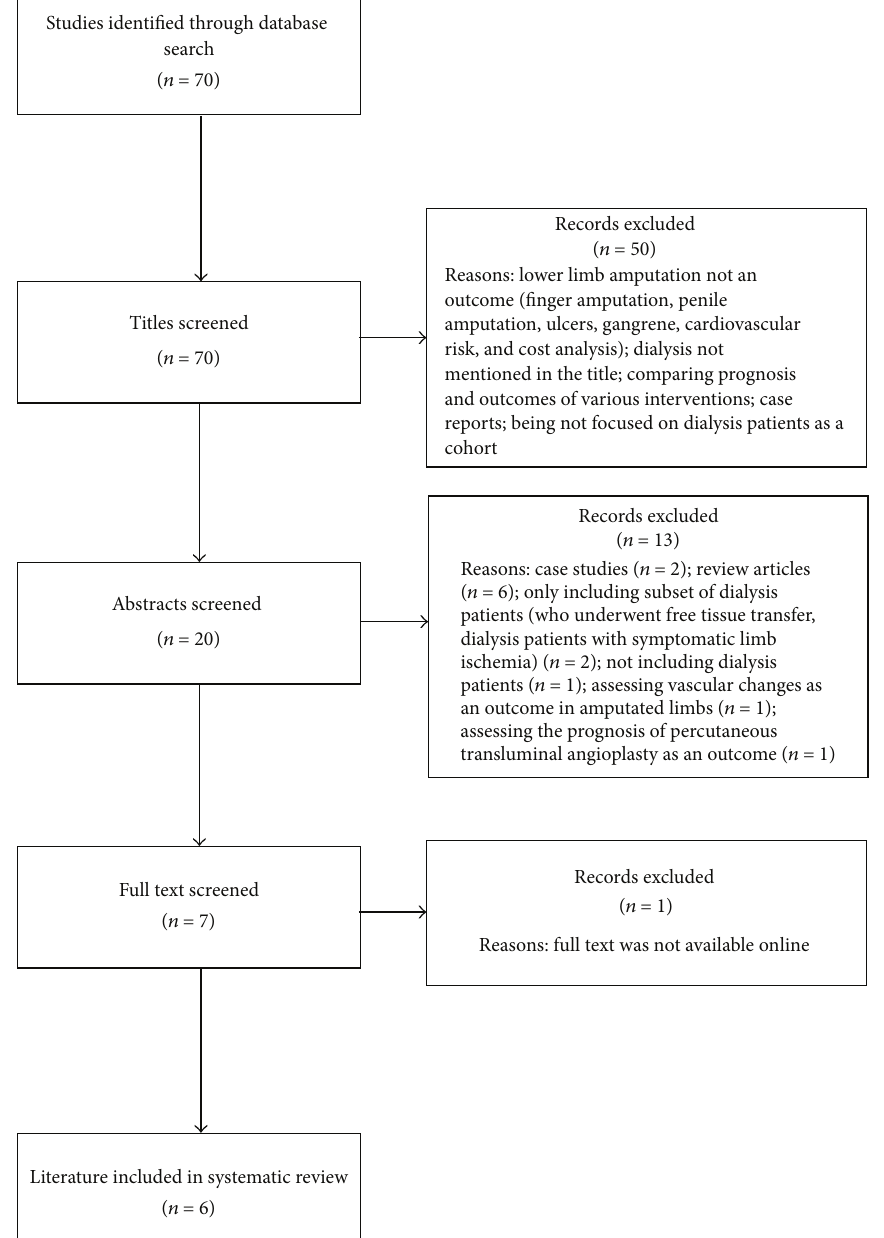
Figure 1: Flow diagram to illustrate the studies identified for this